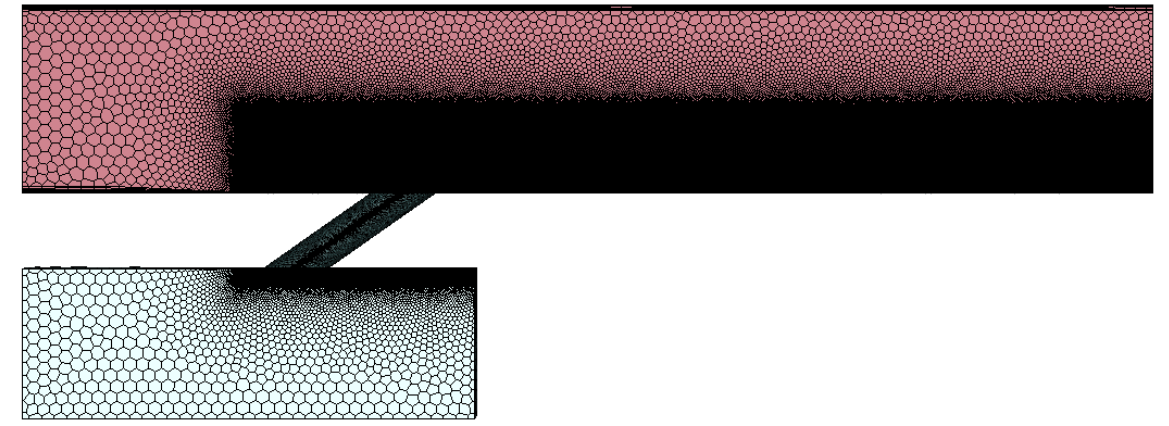
Figure 2. Schematic diagram of the computational domain grid.